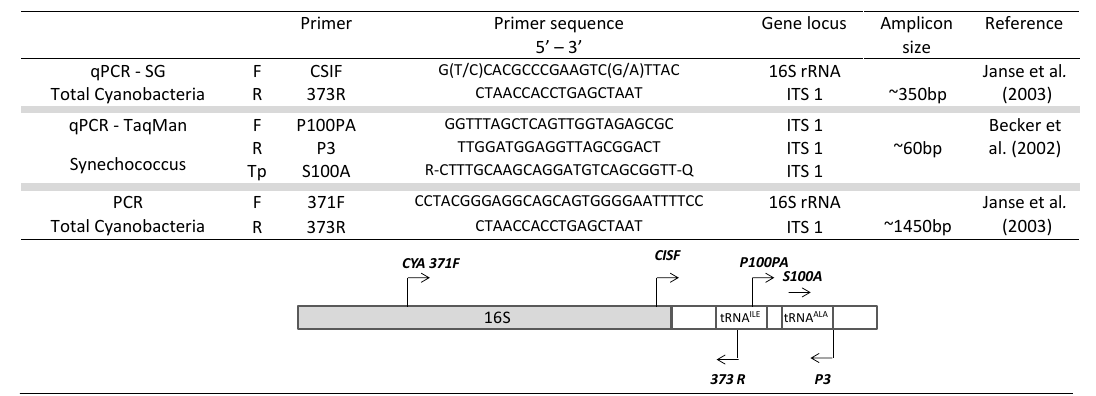
Table 1. Size of amplicons, oligonucleotide primers and TaqMan probes used for PCR and qPCR to target total cyanobacteria and Synechococcus populations. F = forward, R = reverse, Tp = Taq man probe, R = reporter, Q = quencher. Target positions of PCR and qPCR primers and probes in the ribosomal operon of Synechococcus spp. are illustrated: the arrows indicate the 5 0 to 3 0 orientation of the oligonucleotides.